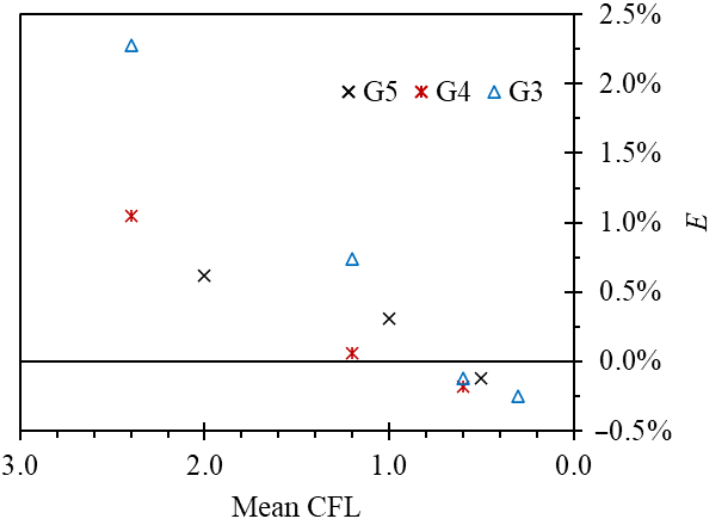
Figure 15. Influence of time-step size on the oscillation frequency for the overset mesh method in reference to results obtained with the layering method of the same time-step size and grid size. Series correspond to different grid sizes.